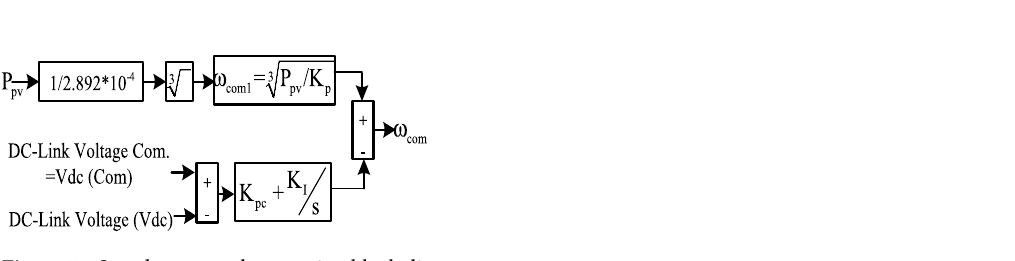
Figure 7. Speed command generation block